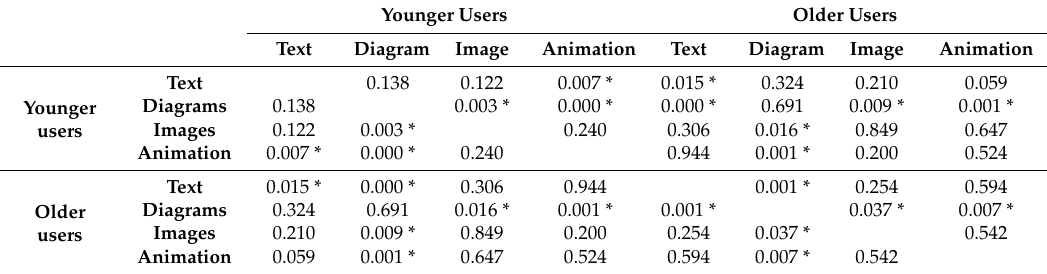
Figure 15. Comparison of the screen results of younger and older users. Table 21. Post-hoc test of younger and older users’ overall reactions to the four interfaces.